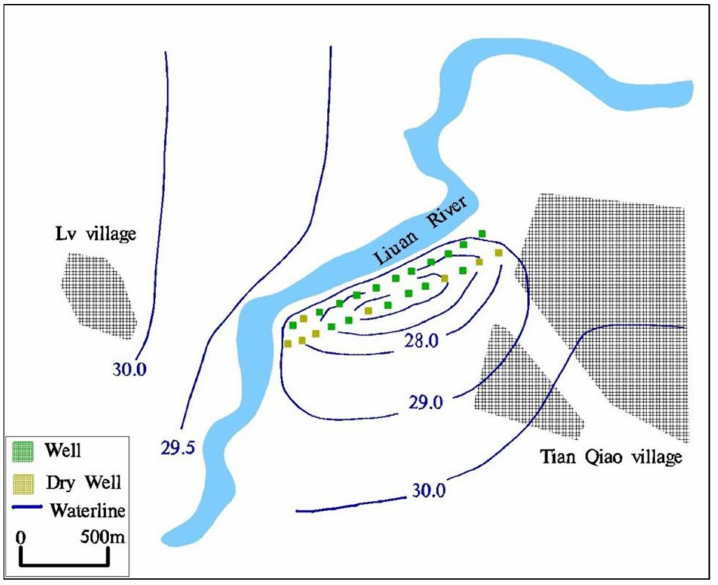
Figure 9. Water level flow field 32 days after